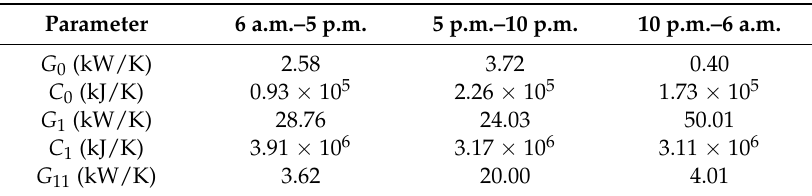
Table 1. Optimal Parameters Values.